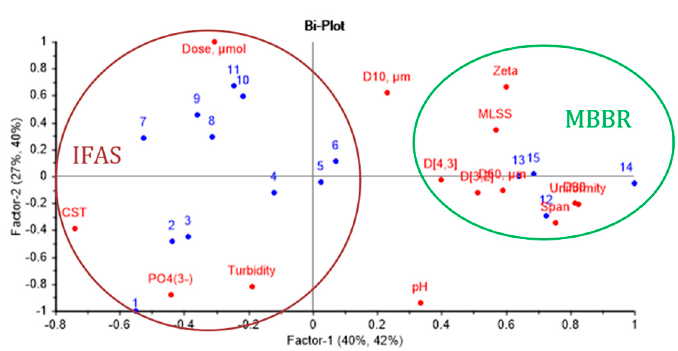
Figure 12. Bi-plot of effects of chemical enhancer in Total Recycle Tests with Mixed Liquors from MBBR and IFAS.